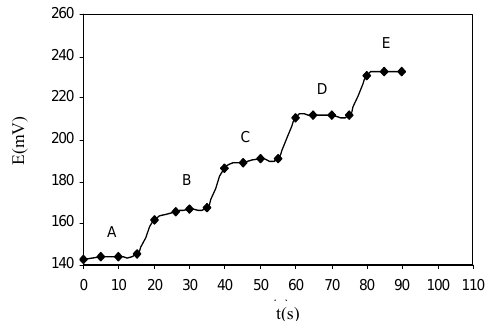
Figure 4. Dynamic response time of the holmium electrode for step changes in the Ho 3+ concentration: A) 1.0 × 10 -6 M, B) 1.0 × 10 -5 M, C) 1.0 × 10 -4 M, D) 1.0 × 10 -3 M, E) 1.0 × 10 -2 M